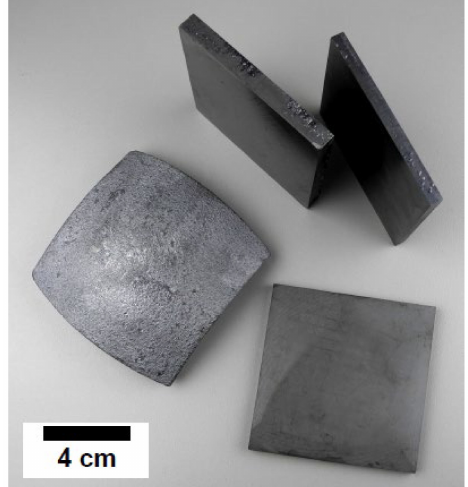
Figure 3. Siliconized and ground RBBC plates with varying thicknesses and a curved